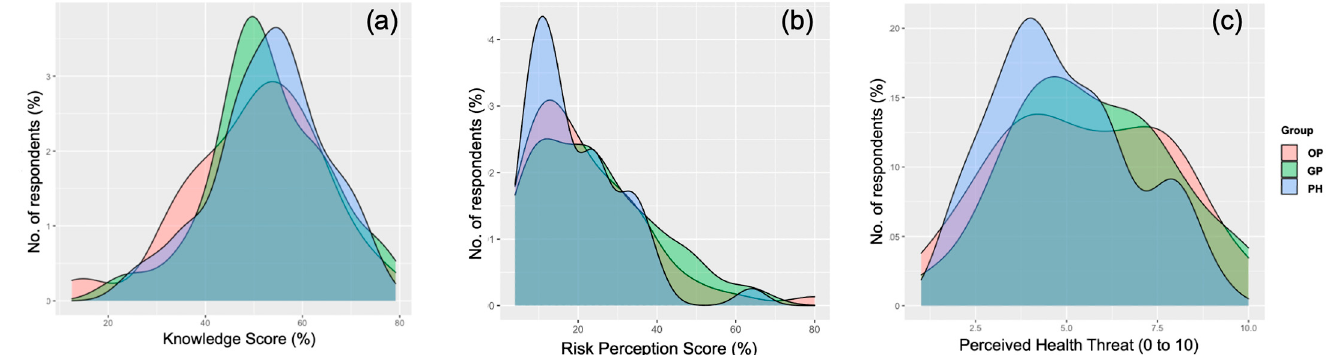
Figure 3. Density plots for: ( a ) Knowledge Score in 156 Italian physicians participating into the survey; ( b ) Risk Perception Score (RPS); ( c ) Perceived burden on National Health Service of Mon- keypox, all of them broken down by occupational group: Occupational Physicians (OP); General Practitioners (GP); Public Health professionals (PH).